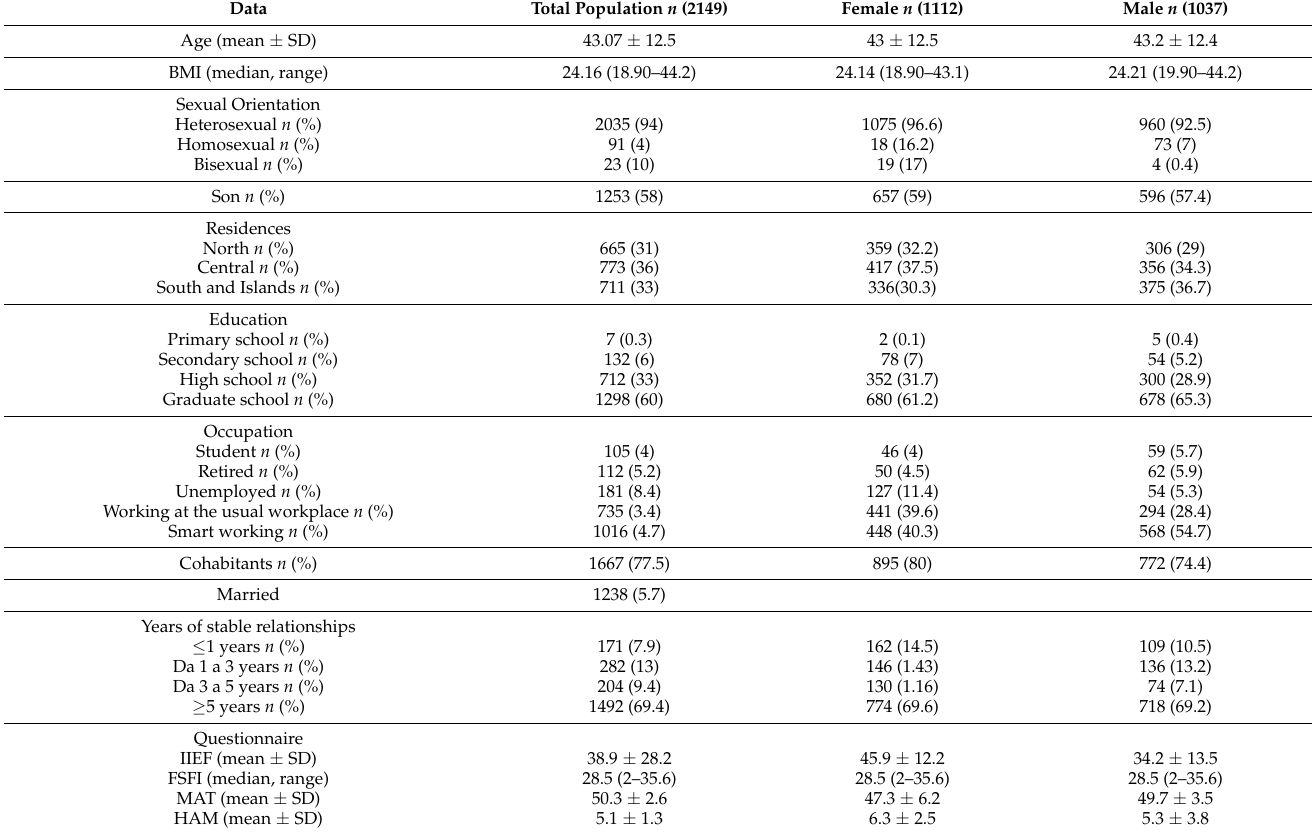
Table 2. The demographic data of the general population and female and male